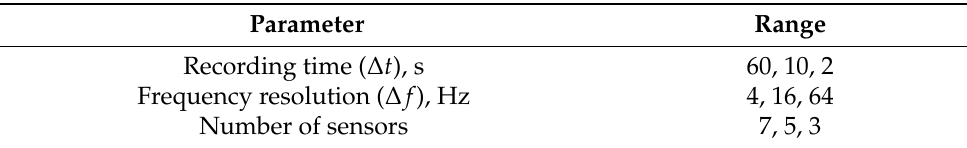
Table 5. Parameters for the sensitivity analysis.